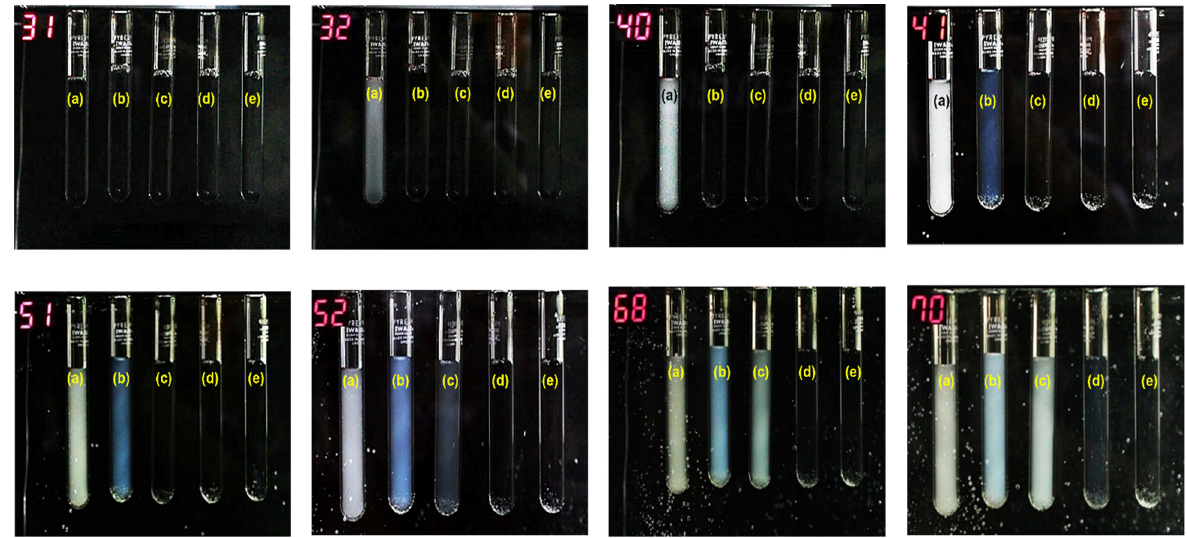
Figure 4. Photographs of H 2 O containing 1 g/L co-polymers with different monomer ratios (NIPAAM:DMAAPS): ( a ) 100:0, ( b ) 95:5, ( c ) 90:10, ( d ) 85:15, and ( e ) 80:20 at various temperatures.